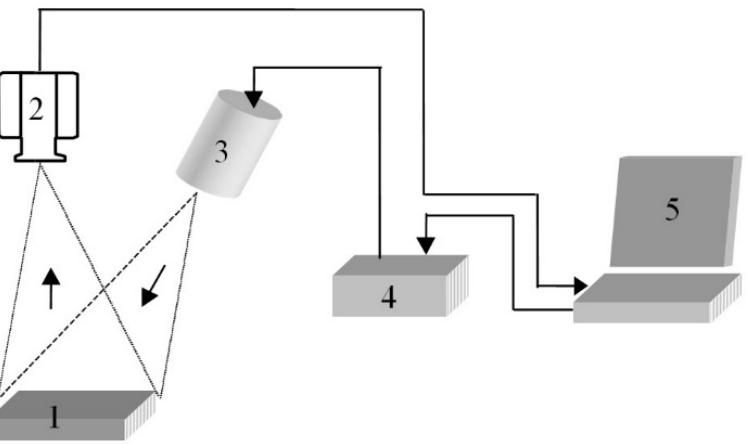
Figure 3. Diagnostic setup using pulse thermography: 1—object under test, 2—thermovision camera, 3—source of thermal radiation, 4—triggering system, 5—microcomputer.